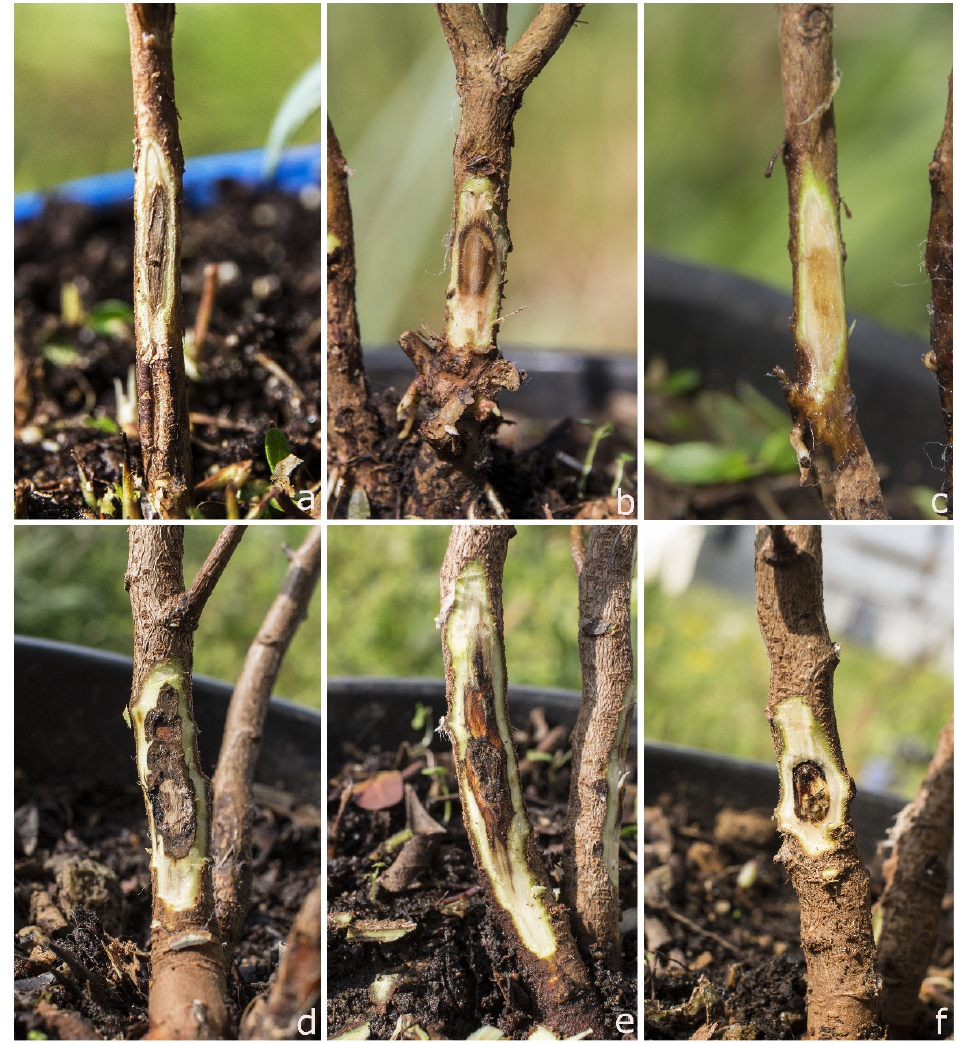
Figure 5. Symptoms observed on myrtle and lentisk seedlings 20 days after inoculation with Phytophthora mediterranea ( a , d ) and P. cinnamomi ( b , e ). Control seedlings ( c , f ). Table 4. Mean lesion length (cm) ( ± standard deviation) caused by Phytophthora mediterranea (CB84) and P. cinnamomi (CB21) on myrtle (M) and lentisk (L) seedlings and percentage